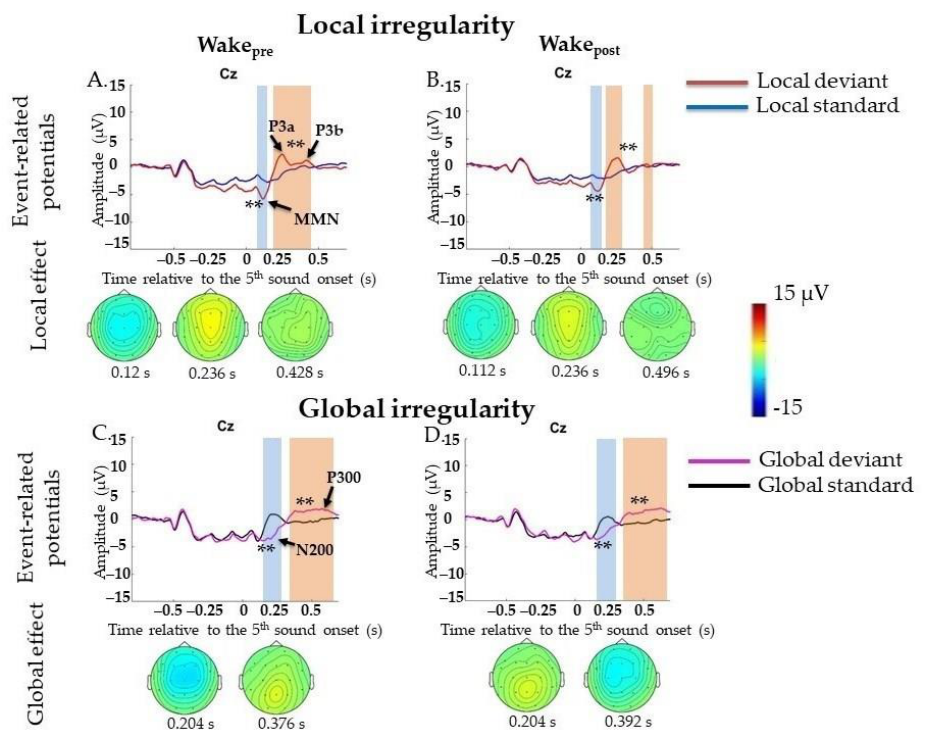
Figure 2. Event-related potentials (ERPs) to violation of local and global regularities in the waking state before (Wake pre ) and after (Wake post ) sleep. Wake pre , performance before sleep; Wake post , performance after sleep; s, second; red line, averaged local deviants; blue line, averaged local standards; magenta line, averaged global deviants; black line, averaged global standards; local effect, local deviants minus local standards; global effect, global deviants minus global standards. ( A , B ) Local mismatch response in EEG in Wake pre session and Wake post session. ( C , D ) Global mismatch response in EEG in Wake pre session and Wake post session. The blue-shaded region is a pool of negative clusters. The orange-shaded region is a pool of positive clusters. ** p < 0.01. Topographies of either local or global effect are shown for the maximum of ERP peak